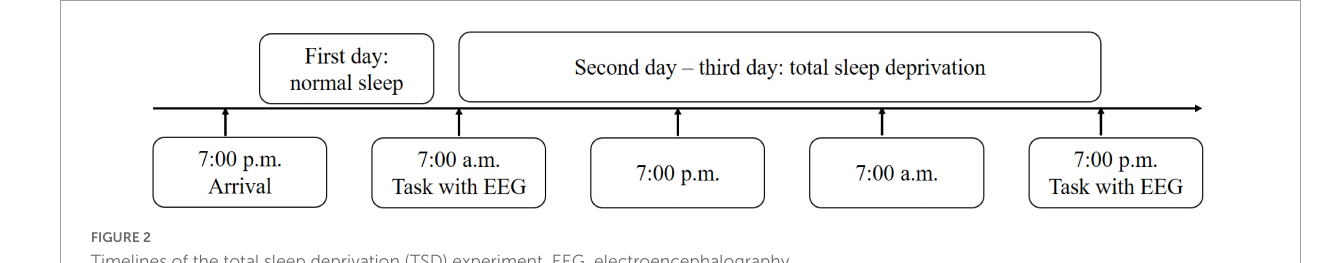
FIGURE2 Timelines of the total sleep deprivation (TSD) experiment. EEG, electroencephalography.